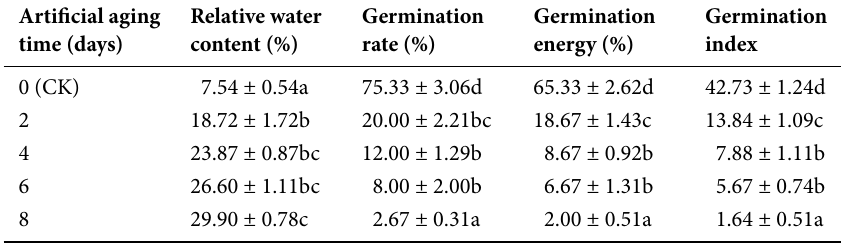
Table 1 Effects of artificial aging on seed germination and relative water content of Aegilops tauschii seeds.